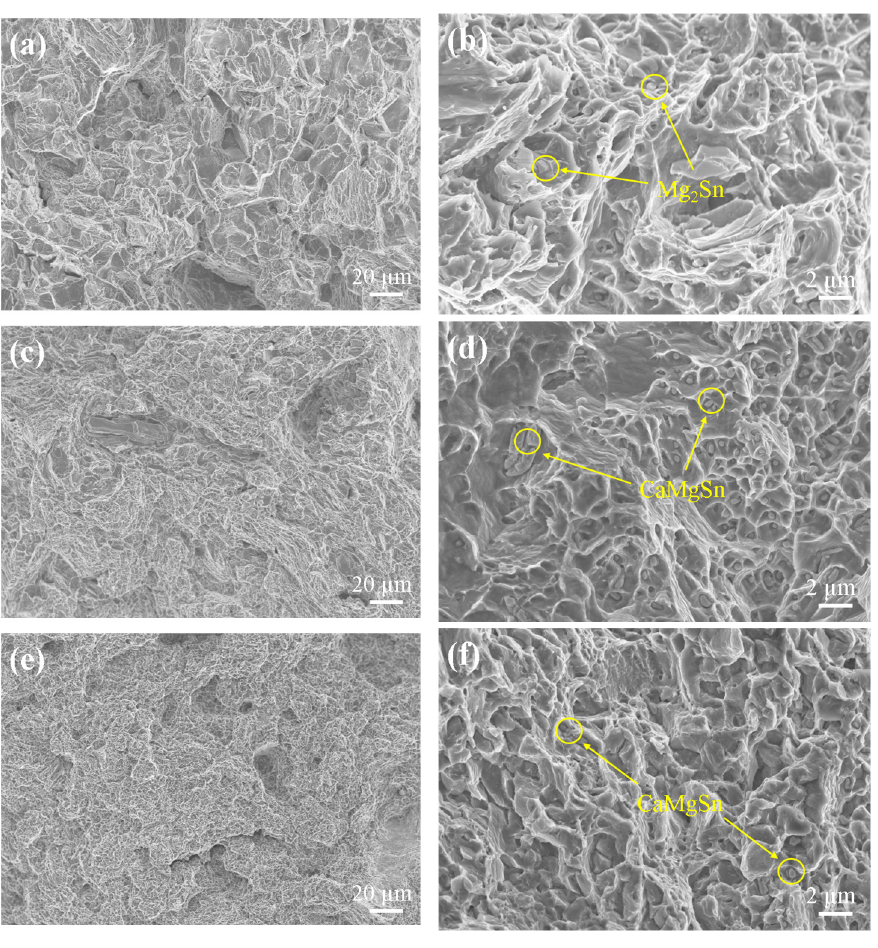
Figure 9. SEM fracture morphology of as-extruded alloys tensile fracture specimen: ( a , b ) T3, ( c , d ) TX31, ( e , f ) TXK311 (( b , d , f ) are partial enlarged views of ( a , c , e )).